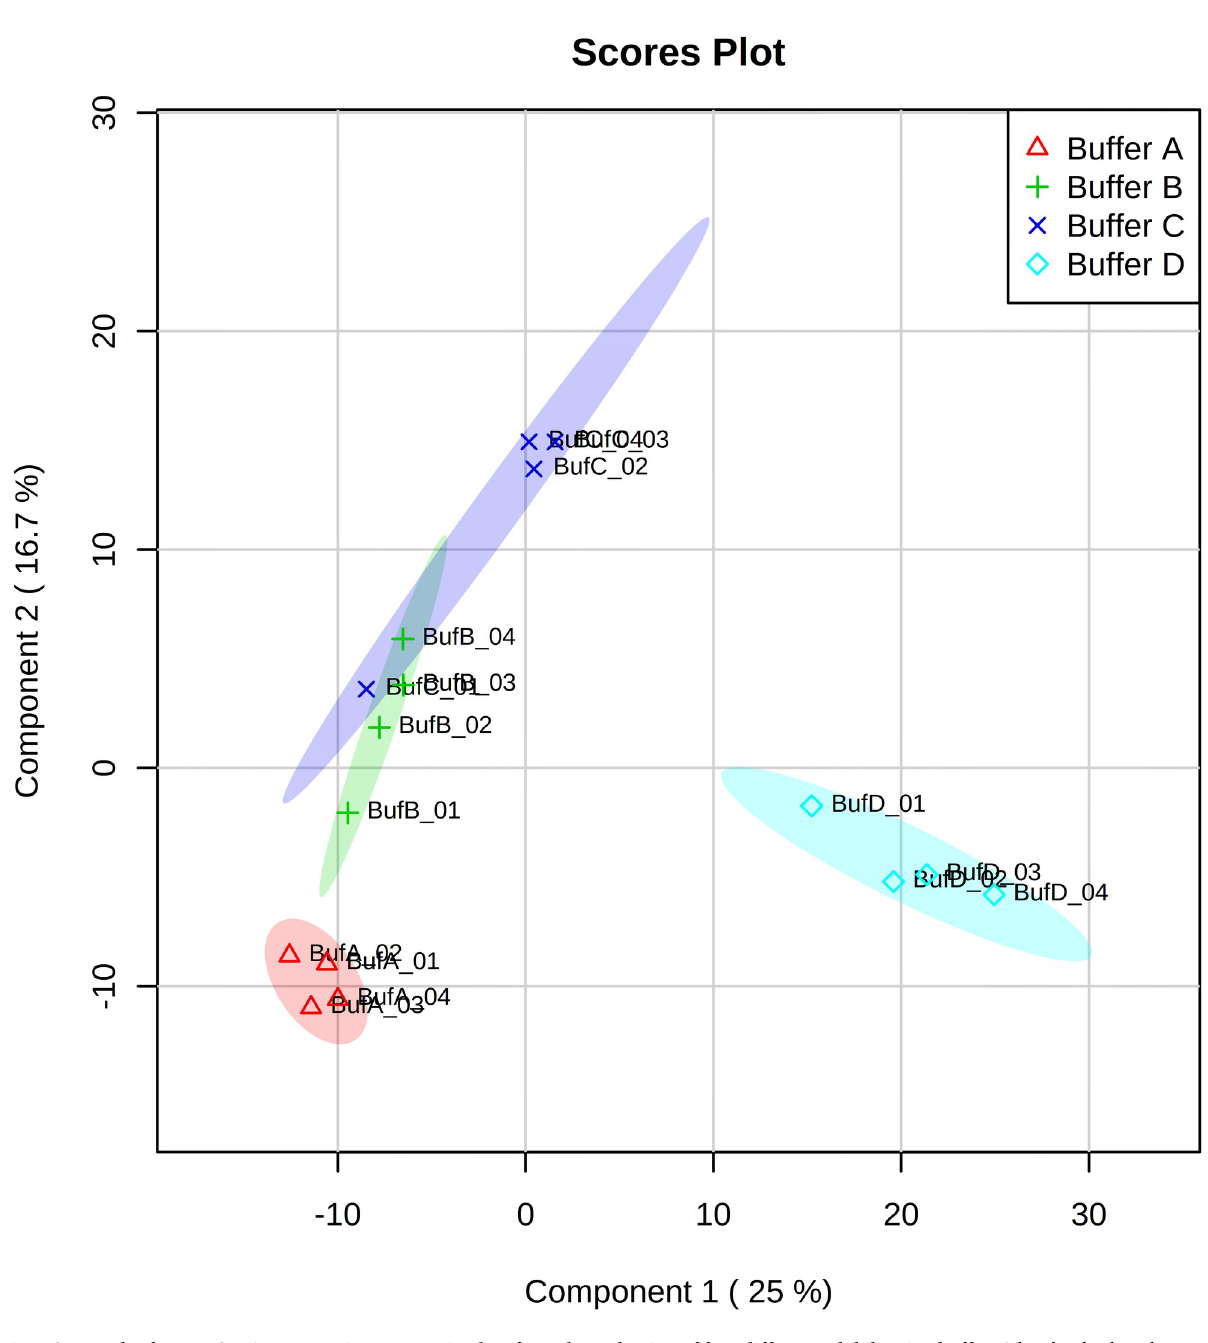
Fig 6. Scores plot from PLS-DA representing proteomics data from the evaluation of four different solubilization buffers. The plot displays the grouping of buffers used in this study (A-D). Buffer A: Urea/thiourea/CHAPS; Buffer B: Urea/CHAPS; Buffer C: Urea/Sodium deoxycholate; Buffer D: Sodium